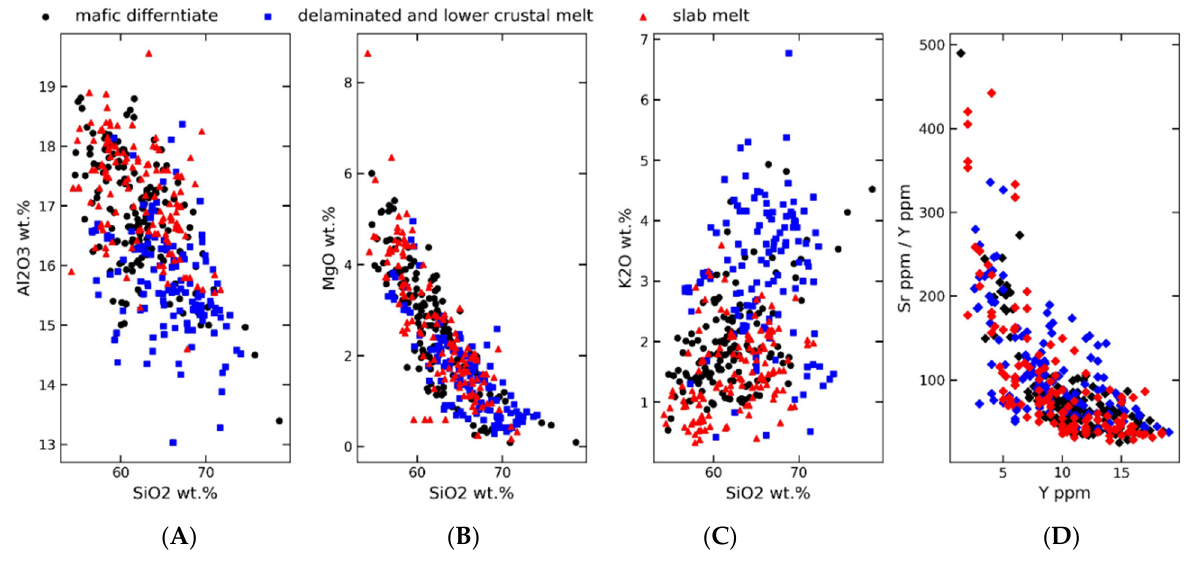
Figure 1. Variations of SiO 2 vs. MgO ( A ), SiO 2 vs. Al 2 O 3 ( B ), SiO 2 vs. K 2 O ( C ) and Sr/Y vs. Y ( D ) in adakites formed through slab melting ( n = 141) [38,40,41,43,45,48,51,52,55,56,64,103,105], underplat- ing and lower crustal melting ( n = 160) [66,68,69,71–73,106–112] and high-pressure fractionation of mafic magmas ( n = 156) [74–77,102,113–115].